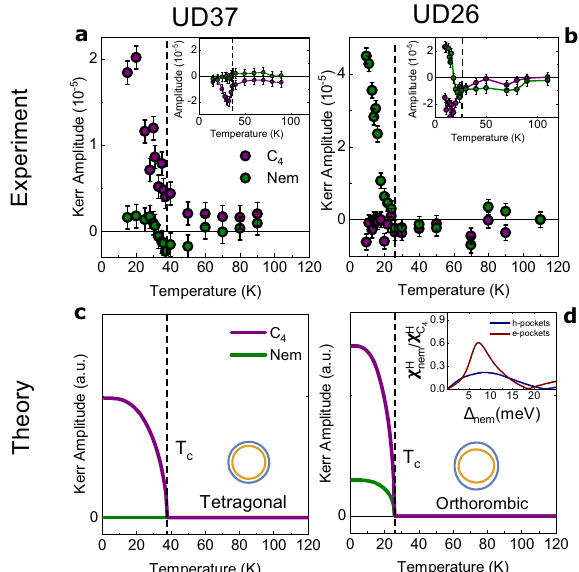
Fig. 3 Instantaneous Kerr response. Temperature dependencies of the amplitude of the fi tted instantaneous Kerr signals in the C 4 symmetric (C 4 ) and nematic (nem) channels for UD37 ( a ) and UD26 ( b ). Insets: Temperature dependencies of the amplitude of the fi tted SC decaying signals. Calculated temperature dependence of Higgs contribution of the hole pockets to the instantaneous Kerr signals in the C 4 symmetric (C 4 ) and nematic (nem) channels for a tetragonal ( c ) and orthorombic ( d ) symmetry of the electronic dispersion relation. The shape of the Fermi surfaces of our model is represented in blue and yellow. Inset: Ratio of the nematic and C 4 symmetric components of the Higgs response as a function of the nematic order parameter for the hole (blue) and electron pockets (red). Error bars are de fi ned as the standard